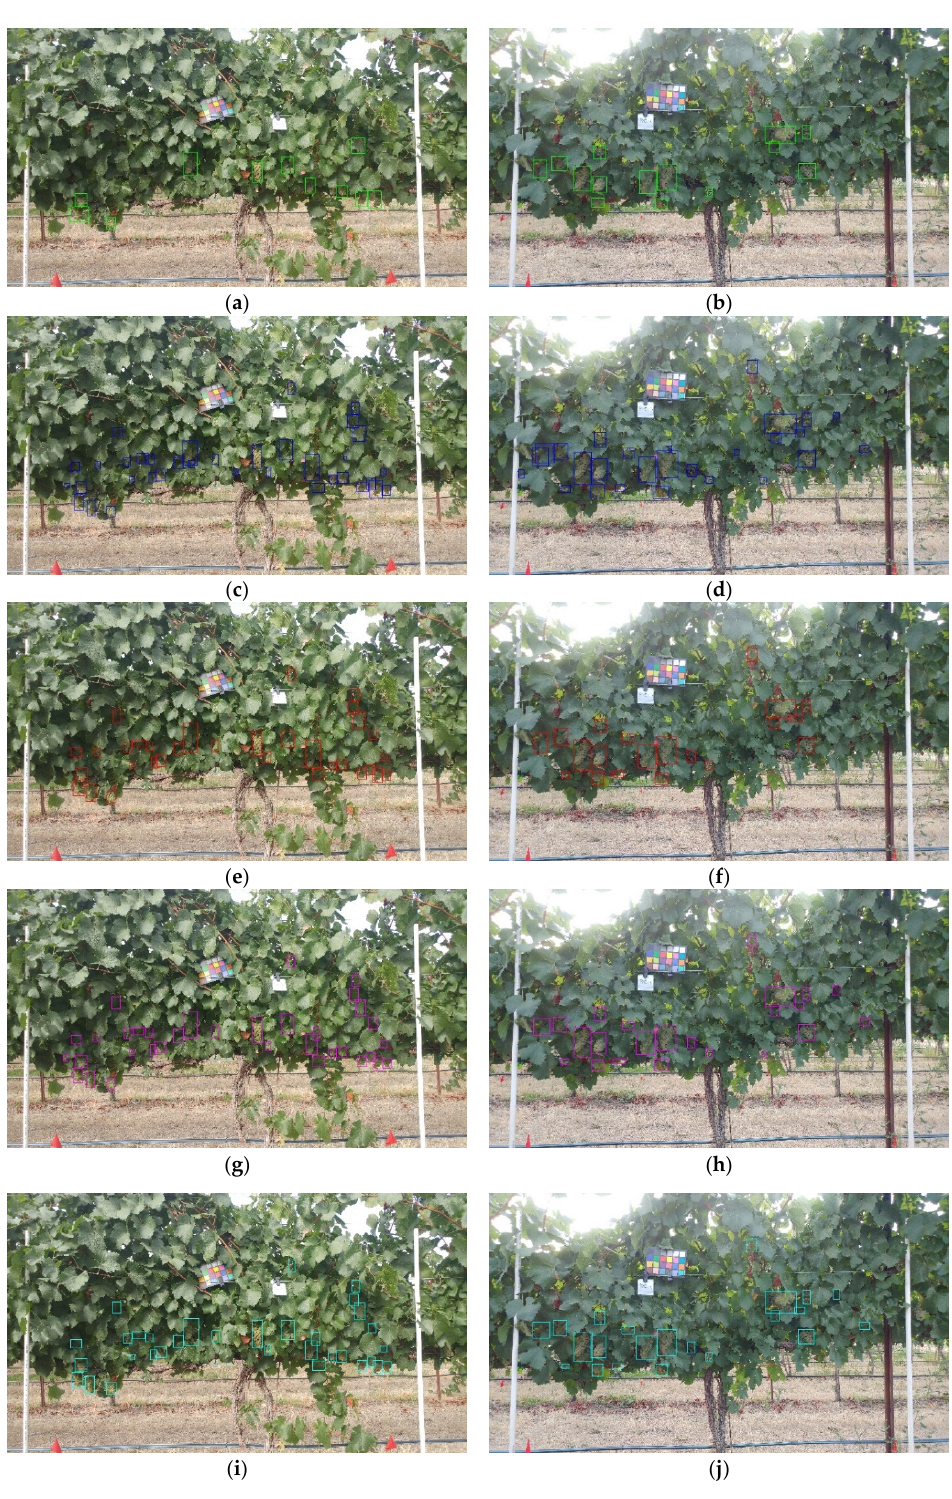
Figure A1. Demonstrations of detection results on the test set of Chardonnay (white variety) using ( a , b ) Faster R-CNN (bounding boxes in green color); ( c , d ) YOLOv3 (in blue color); ( e , f ) YOLOv4 (in red color); ( g , h ) YOLOv5 (in magenta color); and ( i , j ) Swin-transformer-YOLOv5 (in cyan color) under sunny (left) and cloudy (right) weathers.